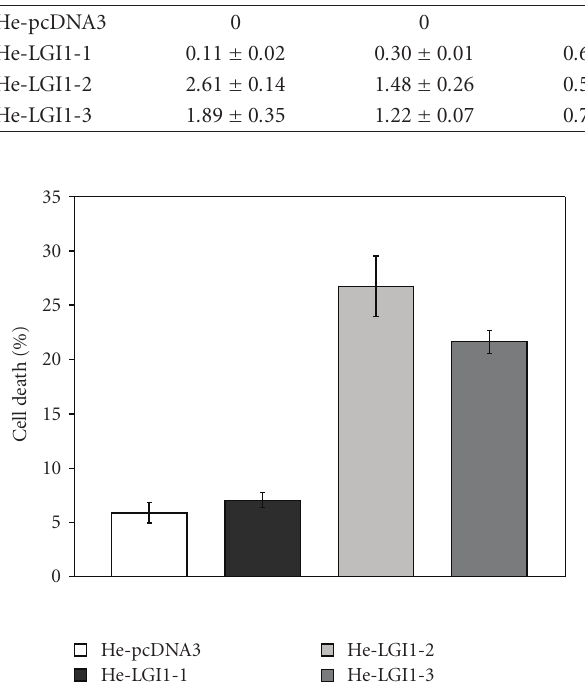
Figure 3: Cell Death. The percentage of cell death was measured on cell clones He-LGI1-1, -2, and -3 and He-pcDNA3 by LDH assays. Cell death was significantly enhanced in He-LGI1-1 in comparison with control cells ( n = 22–26; P = . 02), and it was much greater with cell clones He-LGI1-2 and He-LGI1-3 ( n = 10–26; P < . 001, 22E-18 ).